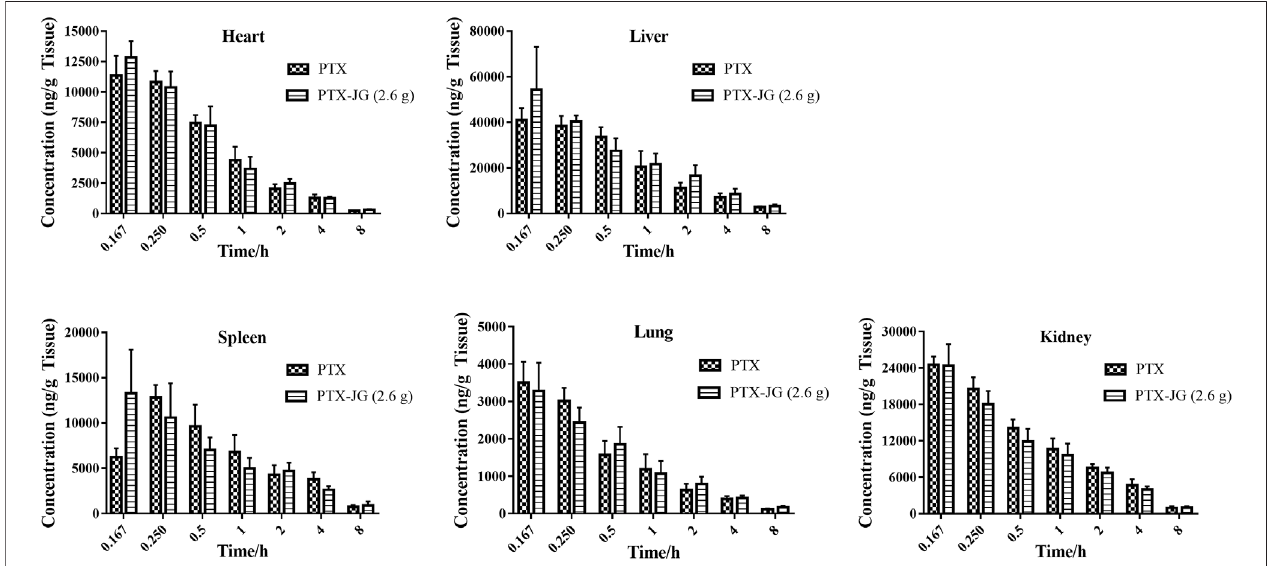
FIGURE 2 | Distribution of PTX in tissue of C57BL/6J mice after the combination of JG at 0.167, 0.25, 1, 2, 4 and 8 h.